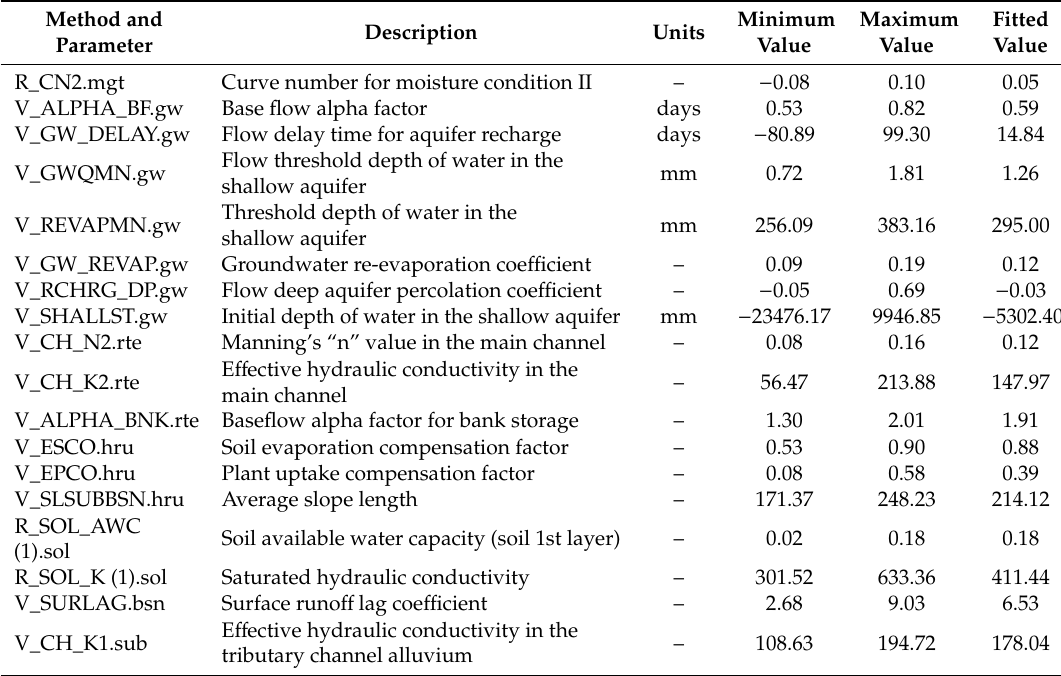
Table 2. The parameters used in the calibration procedure of streamflow. In the legend of methods, R is relative and V is the replacement